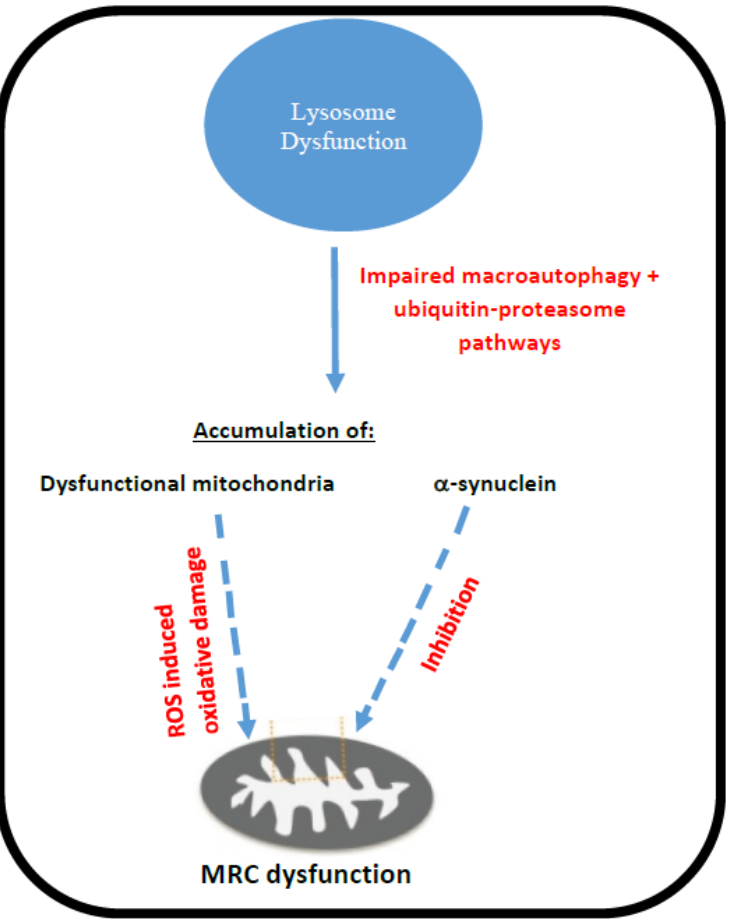
Figure 2. Putative mechanisms of MRC dysfunction in Gaucher disease.